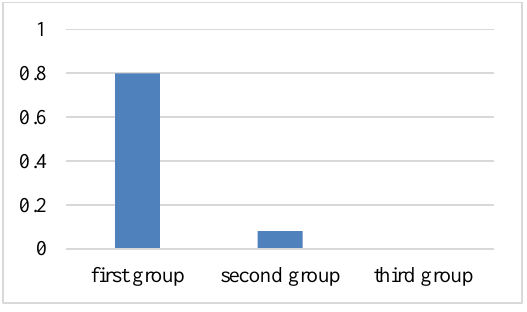
Figure 3. Ridicule mode in autistic children